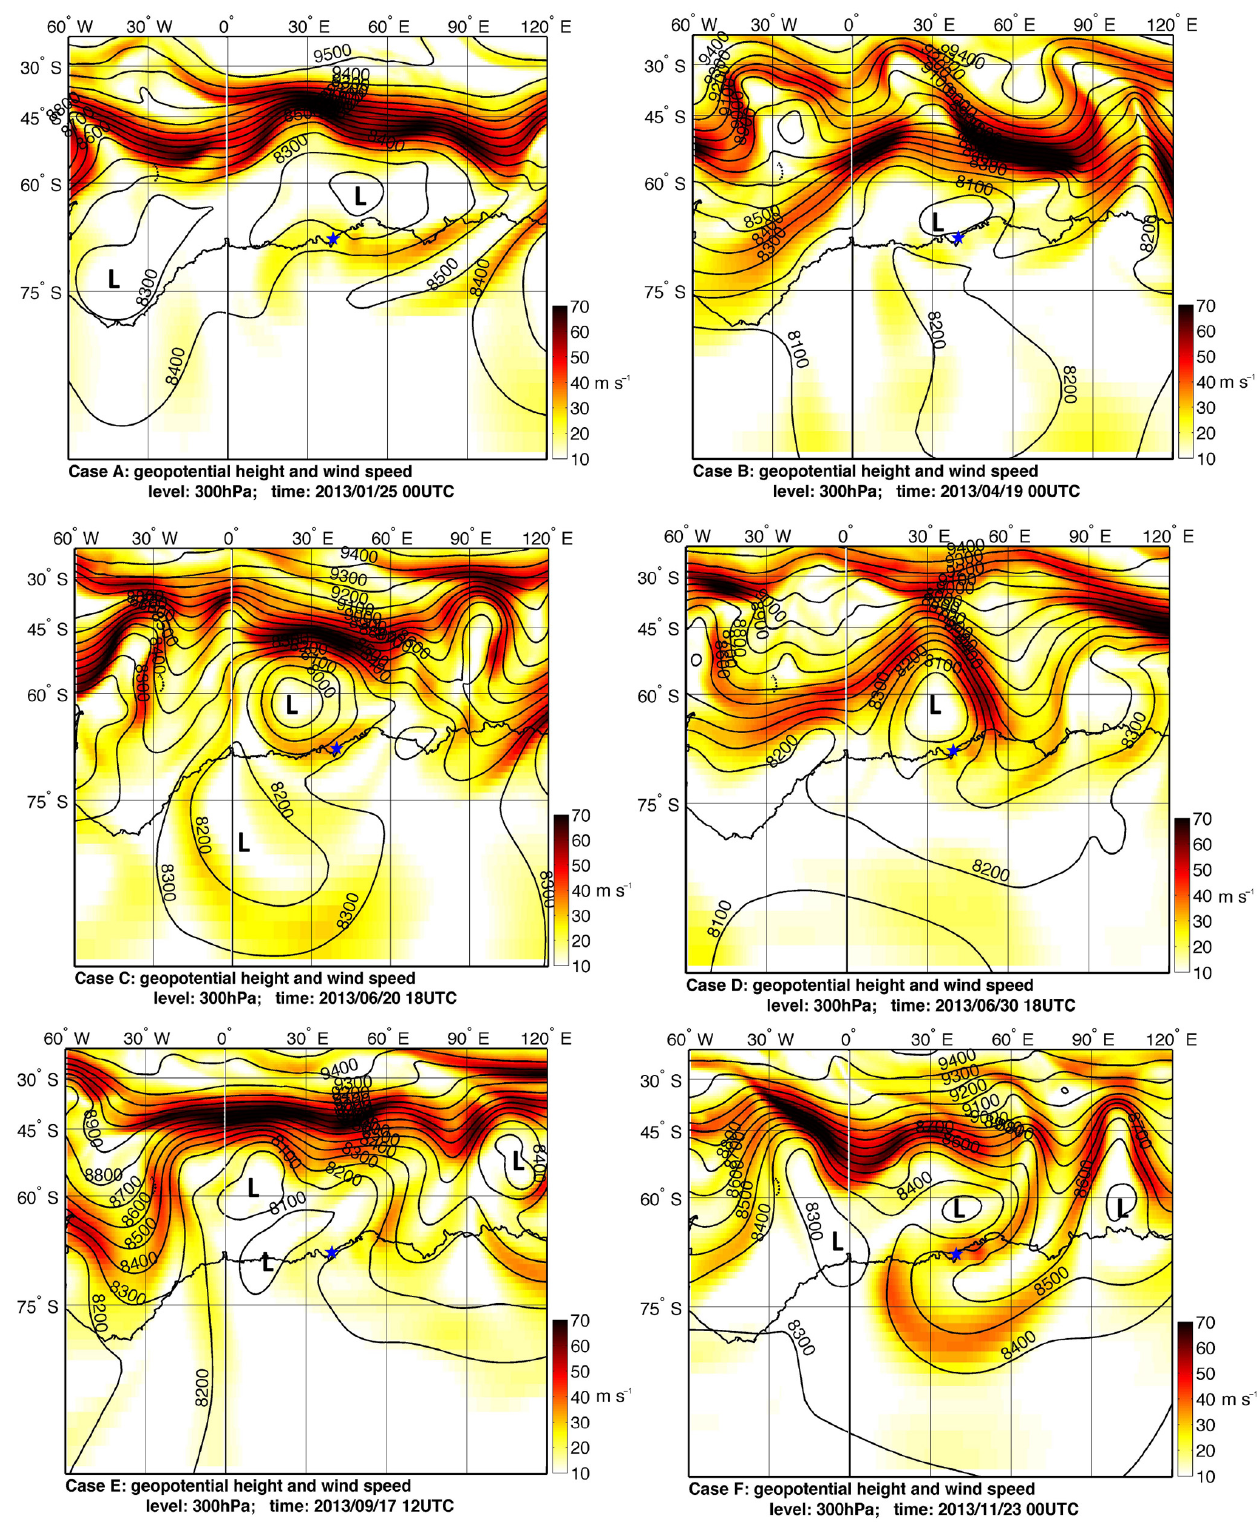
Figure 12. ERA Interim geopotential height (10gpm) and wind speed (ms − 1 ) at 300hPa level for the six cases at the time close to maximum observed horizontal perturbation variance. Position of Syowa Station is denoted by the blue